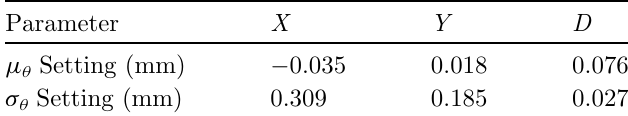
Table 2. Dispersion of